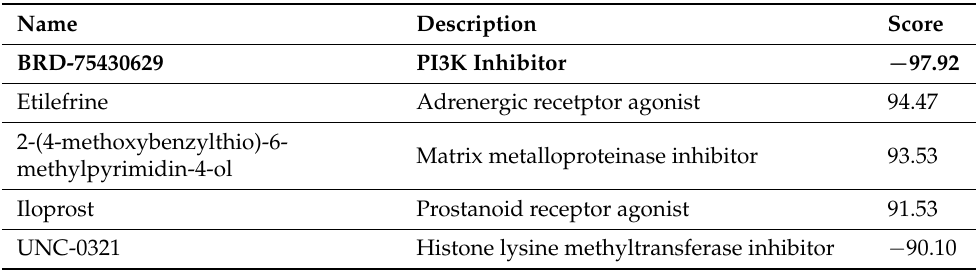
Table 4. Connectivity results between suberic acid-modulated genes in Hs68 cells and compounds in the connectivity map